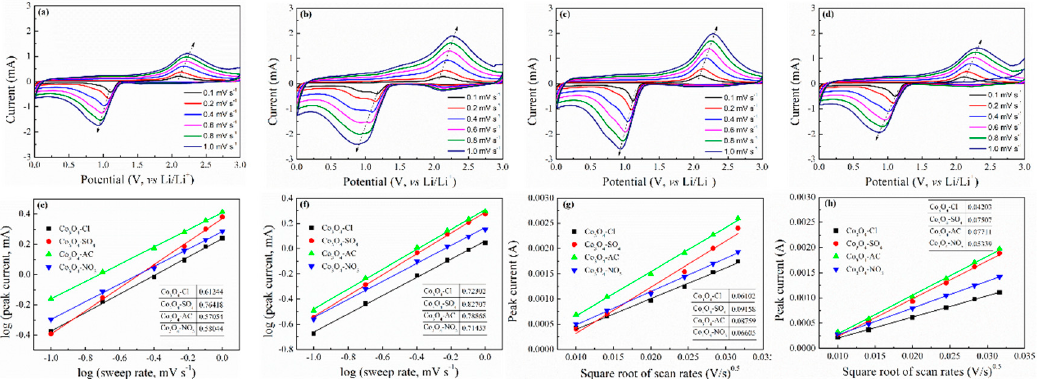
Figure 9. CV curves of ( a ) Co 3 O 4 -Cl, ( b ) Co 3 O 4 -SO 4 , ( c ) Co 3 O 4 -AC, and ( d ) Co 3 O 4 -NO 3 at different scan rates (0.1 mV·s − 1 , 0.2 mV·s − 1 , 0.4 mV·s − 1 , 0.6 mV·s − 1 , 0.8 mV·s − 1 , and 1.0 mV·s − 1 ). The relationship between peak current and scan rate in the ( e ) cathodic and ( f ) anodic process determines the value b in the equation (I = a ν b ). Plot of peak current of ( g ) cathodic reaction and ( h ) anodic reaction versus